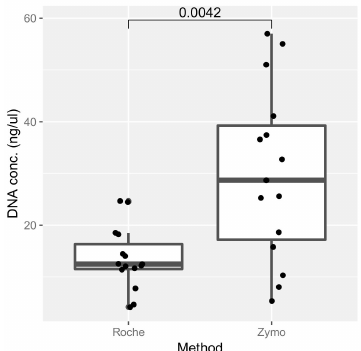
Figure 3. Performance of primer sets in replicating the theoretical (T) composition of amplicon and genomic DNA-based mock communities. Mock communities were subjected to amplification of the ITS region using primer sets P1–P4.